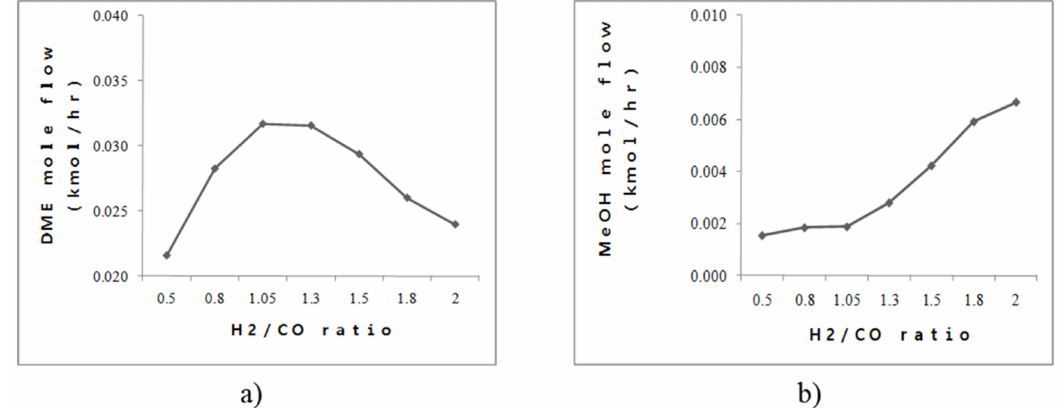
Figure 9. Influence of the H 2 to CO ratio on ( a ) DME and ( b ) methanol mole flow at the outlet of the reactor.